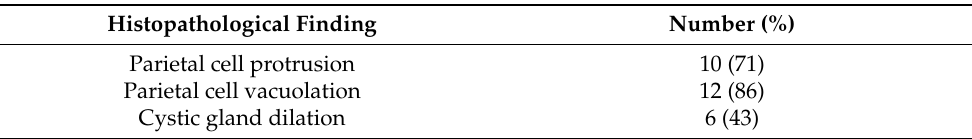
Figure 6. Histopathological findings: ( a ) a dilated gland that contains eosinophilic material with necrotic epithelial fragments; ( b ) parietal cell protrusion and parietal cell vacuolation in the mucosa surrounding a white spot in the fundic gland area. Table 6. Histopathological findings of the 14 patients from whom a biopsy of a white spot area was obtained.